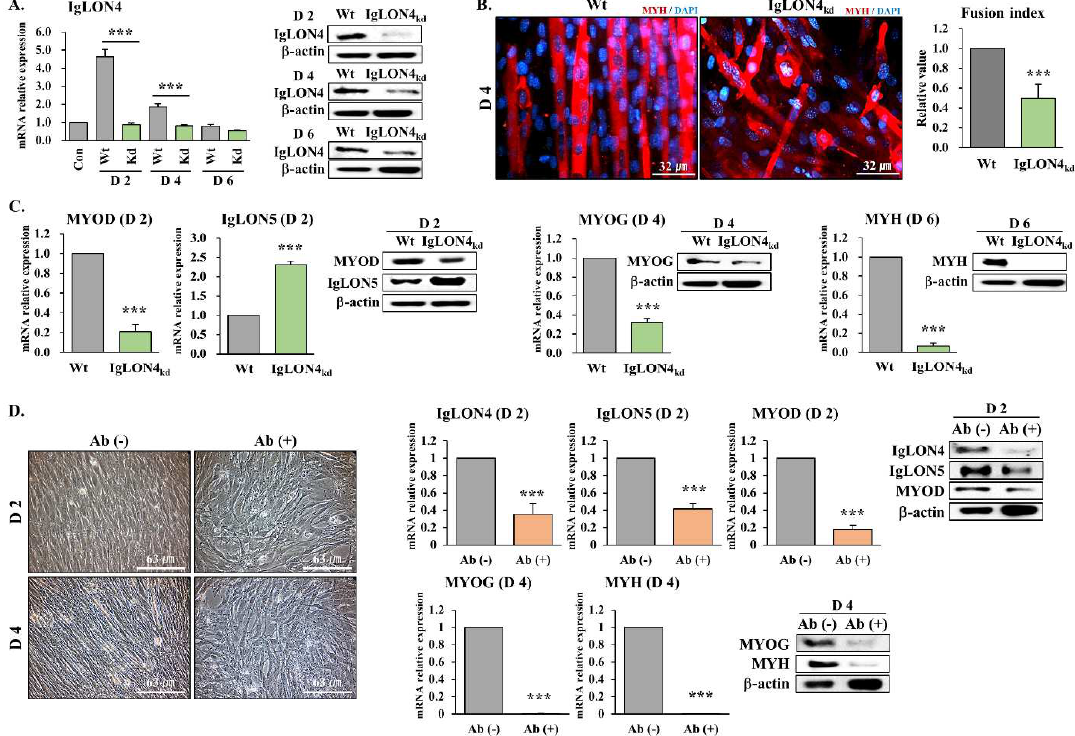
Figure 2. Inhibitory effect of IgLON4 gene and protein expression on C2C12 myoblast differentiation: ( A ) mRNA and protein expressions of IgLON4 as determined by real-time RT-PCR and Western blot analysis in Wt and IgLON4 kd C2C12 myoblasts on differentiation days (DDs) 2, 4, and 6. mRNA levels on DDs 2, 4 and 6 were normalized versus Wt levels. ( B ) Expression of MYH by immunocytochemistry in Wt and IgLON4 kd C2C12 myoblasts on DD4, and IgLON4 kd fusion indices. ( C ) mRNA and protein levels of MYOD, IgLON5, MYOG, and MYH as determined by real-time RT-PCR and Western blot analysis in Wt and IgLON4 kd cells on DDs 2, 4, and 6. mRNA and protein levels were compared at each time point. ( D ) Morphologies of cells treated with or without IgLON4 antibody on DD2 or 4. mRNA and protein expressions of IgLON4, IgLON5, MYOD, MYOG, and MYH in cells treated with or without IgLON4 antibody on DDs 2 or 4. mRNA and protein levels at each time-point were compared. Wt indicates transfection with scrambled vector. Real-time PCR results were normalized to each control (con, before differentiation) and analyzed by t-test. Means ± SDs ( n ≥ 3). * p < 0.05, ** p < 0.01, *** p <